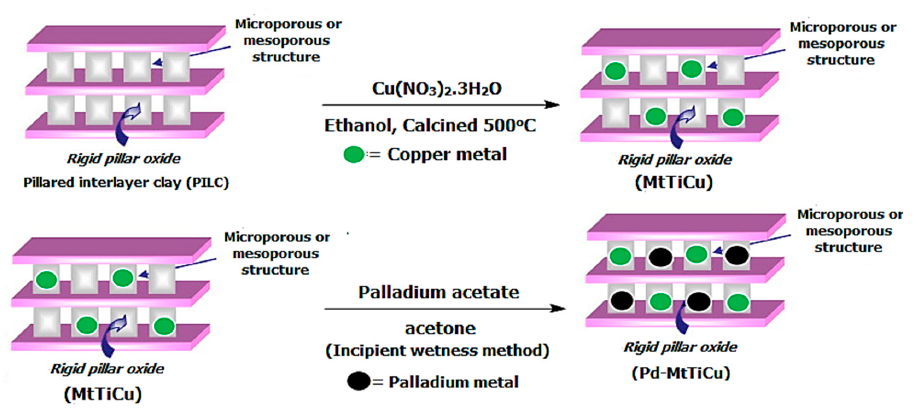
Table 7. MOF-based Cu 2 (BDC) 2 (DABCO) catalyzed synthesis of diphenyl